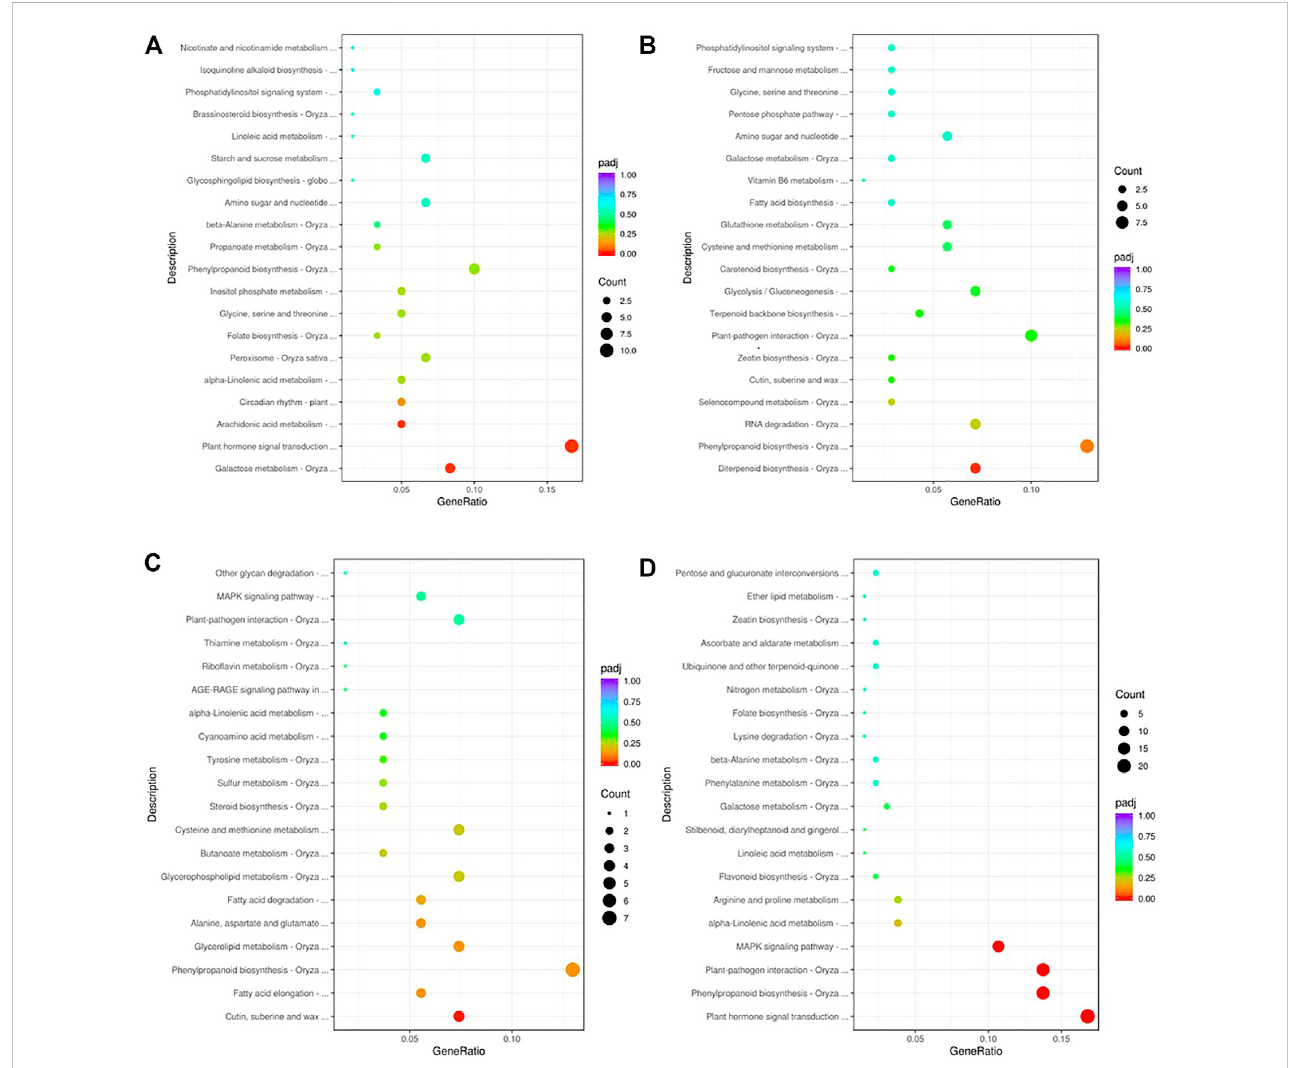
KEGG enrichment analysis of DEGs in roots of two rice landraces. (A) KEGG analysis of upregulated genes of KR. (B) KEGG analysis of downregulated genes of KR. (C) KEGG analysis of up-regulated genes of MR. (D) KEGG analysis of downregulated genes of